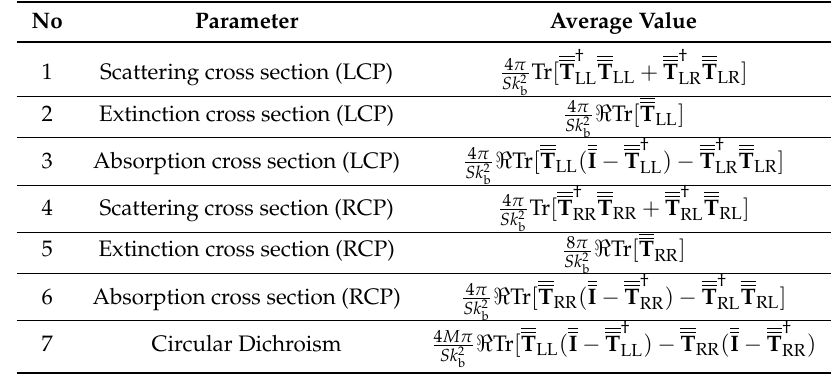
Table 2. Average value of several responses for Left Circularly Polarized (LCP) and Right Circularly Polarized (RCP) light in terms of the components of the helicity based T-matrix of the individual